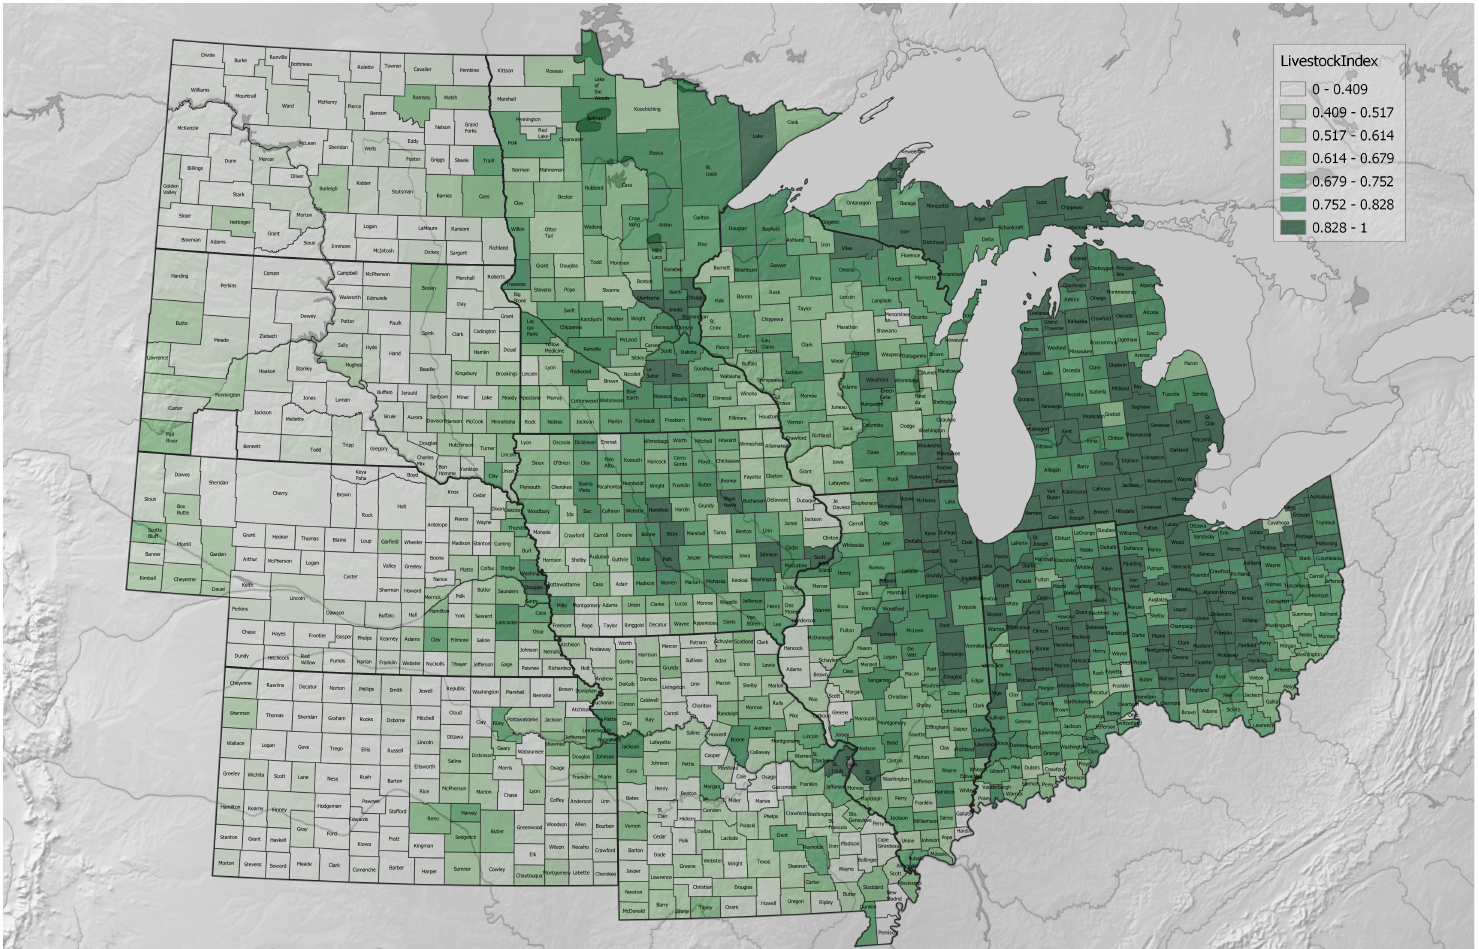
Figure A3. Livestock diversity index, by county, 2017. Values were all rescaled through dividing by the largest value present for any of the counties included here (1.977 in Crawford County, Michigan), as this transformation was applied to the variable data as they were placed into the index expression. Methods for LivestockDiversity are described in the article main text and Supplementary Materials. USDA 2017 Census of Agriculture data [52] were